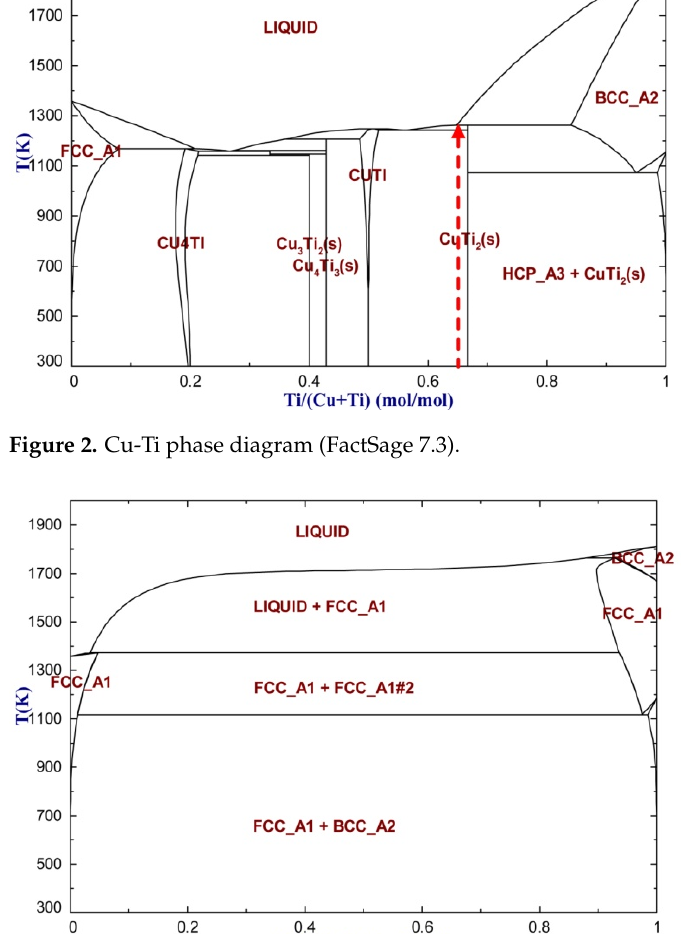
Figure 2. Cu-Ti phase diagram (FactSage 7.3).